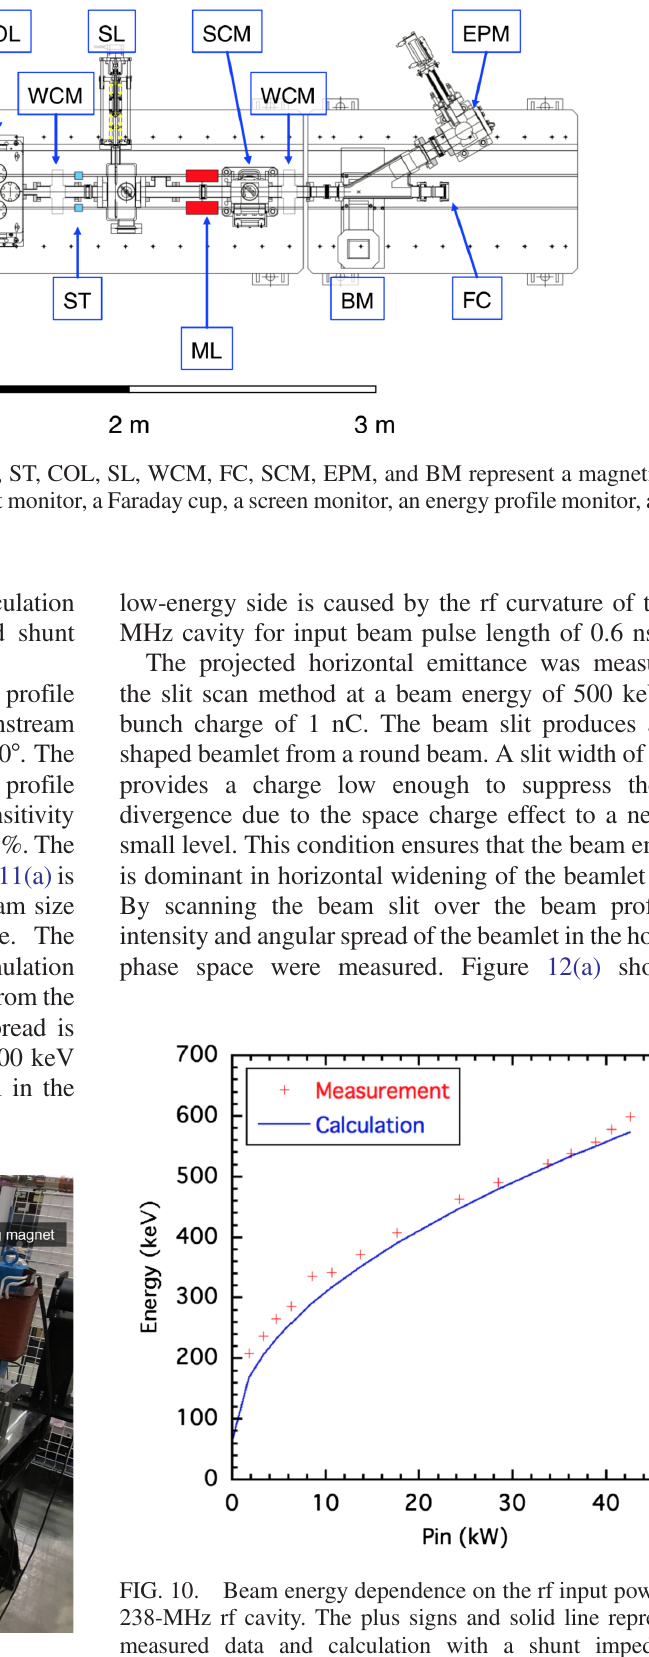
FIG. 9. Picture of the gun test stand.